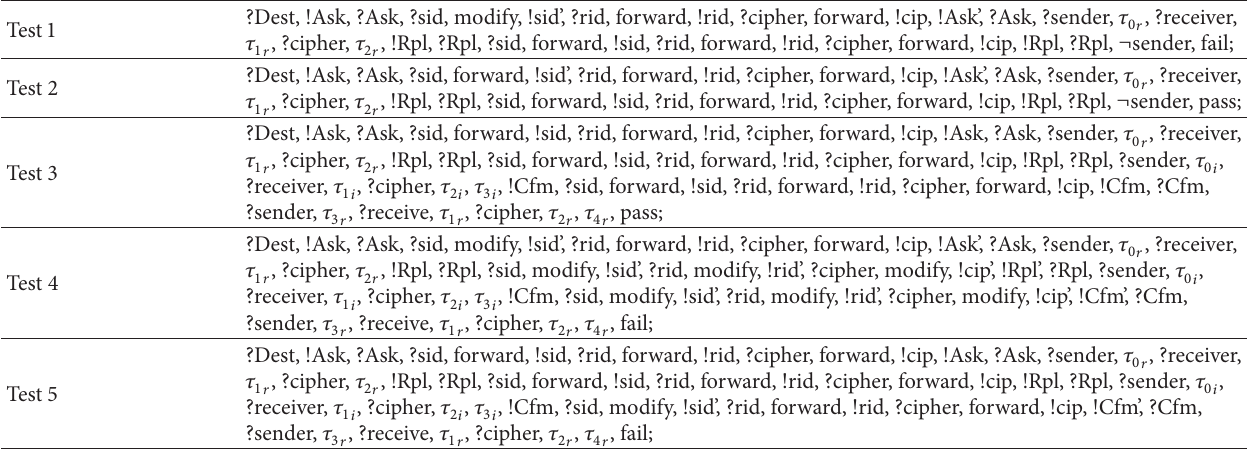
Table 1: Some security test cases for NSPK